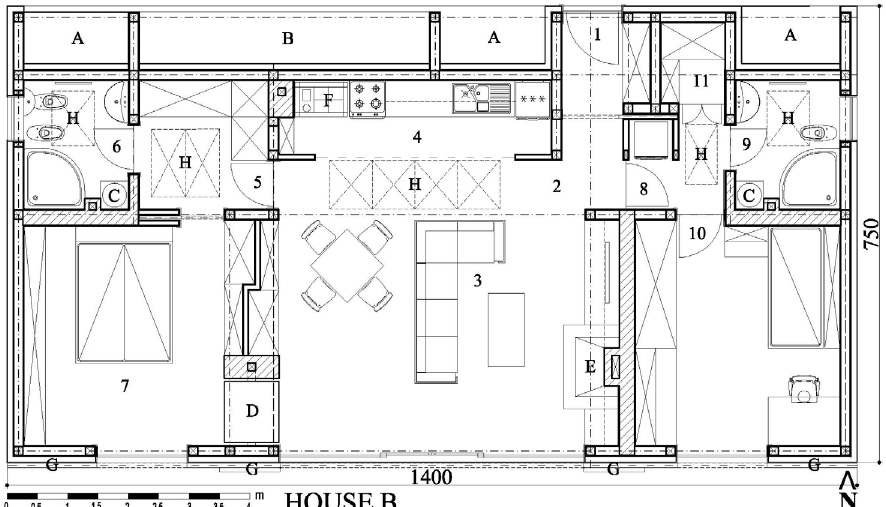
Fig. 7. Plan of House B.